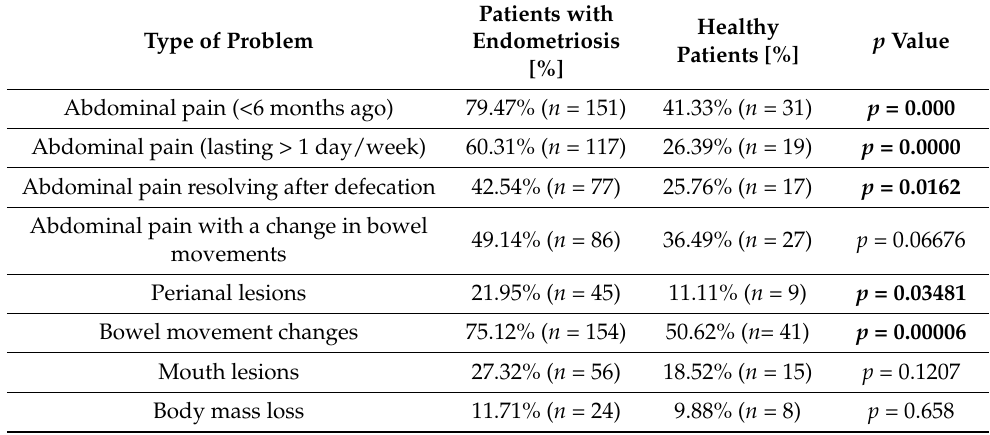
Table 2. Gastrointestinal tract problems in the groups.